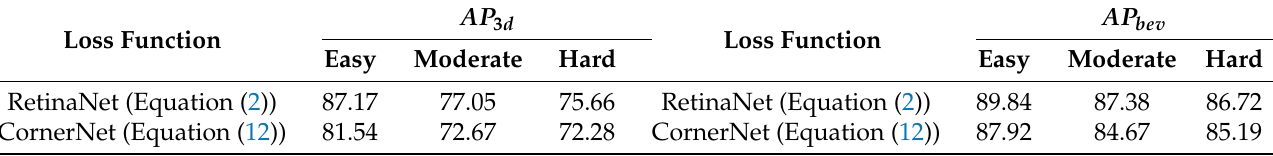
Table 8. Experiments on the loss function. For the focal loss of RetinaNet, we set the cutoff value to 0.8. AP 3 d AP bev Loss Function Loss Function Easy Moderate Hard Easy Moderate Hard RetinaNet (Equation